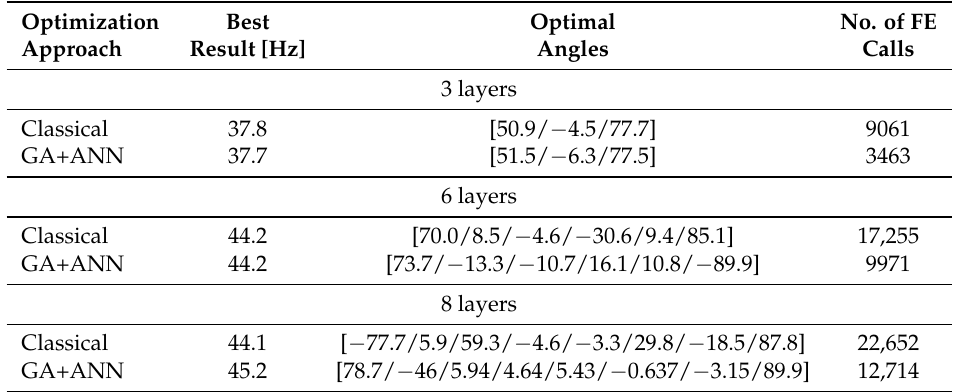
Table 6. Results of f 1 optimization using classical and proposed procedures using MODEL1 with a different number of layers.